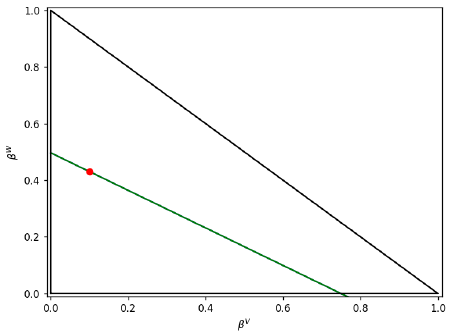
Figure 9. Lines for RR y = 0 and RR w = 0 at z = 0 and T = 80 ◦ C. Note: the red point represents HYSYS